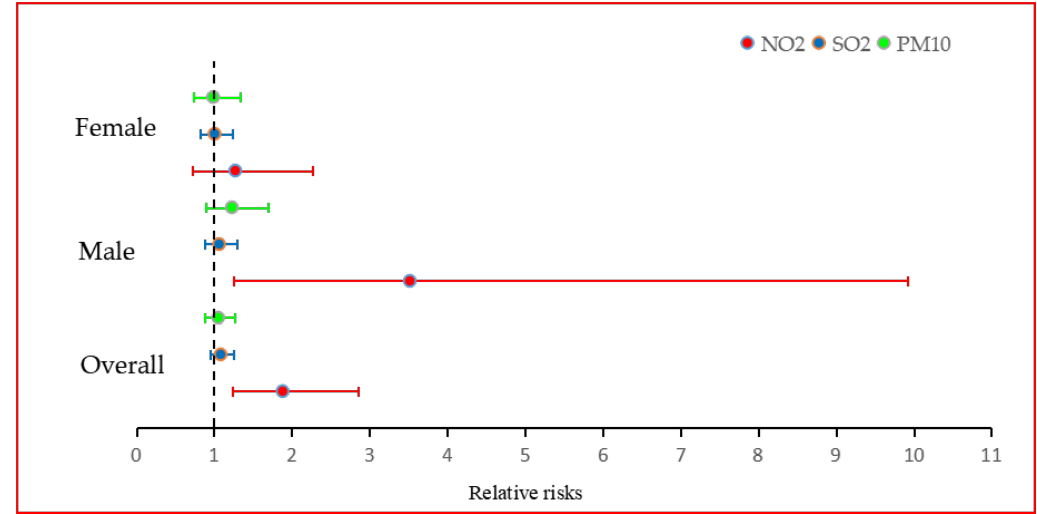
Figure 3. Relative risks of NPC incidence associated with a 10 µ g / m 3 increase in air pollutants concentrations annually lasting for four years.